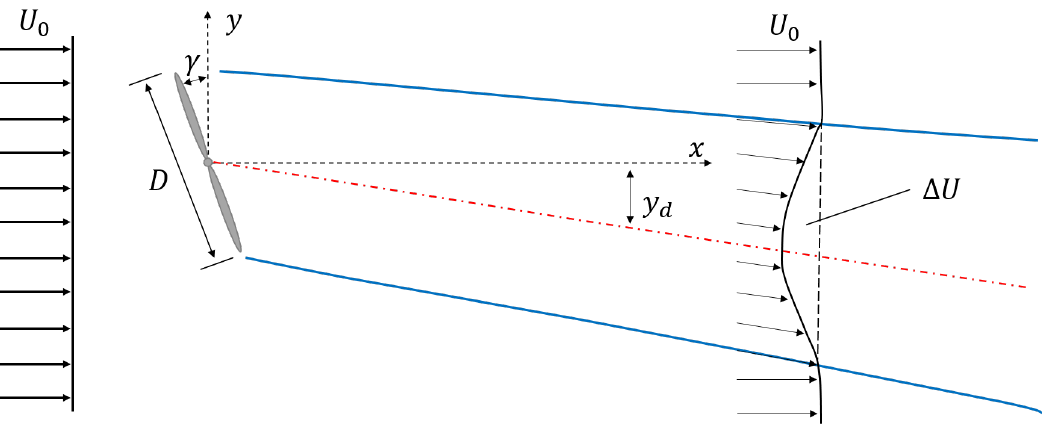
Figure 1. x − y plane of Gaussian wake as described by Qian and Ishihara